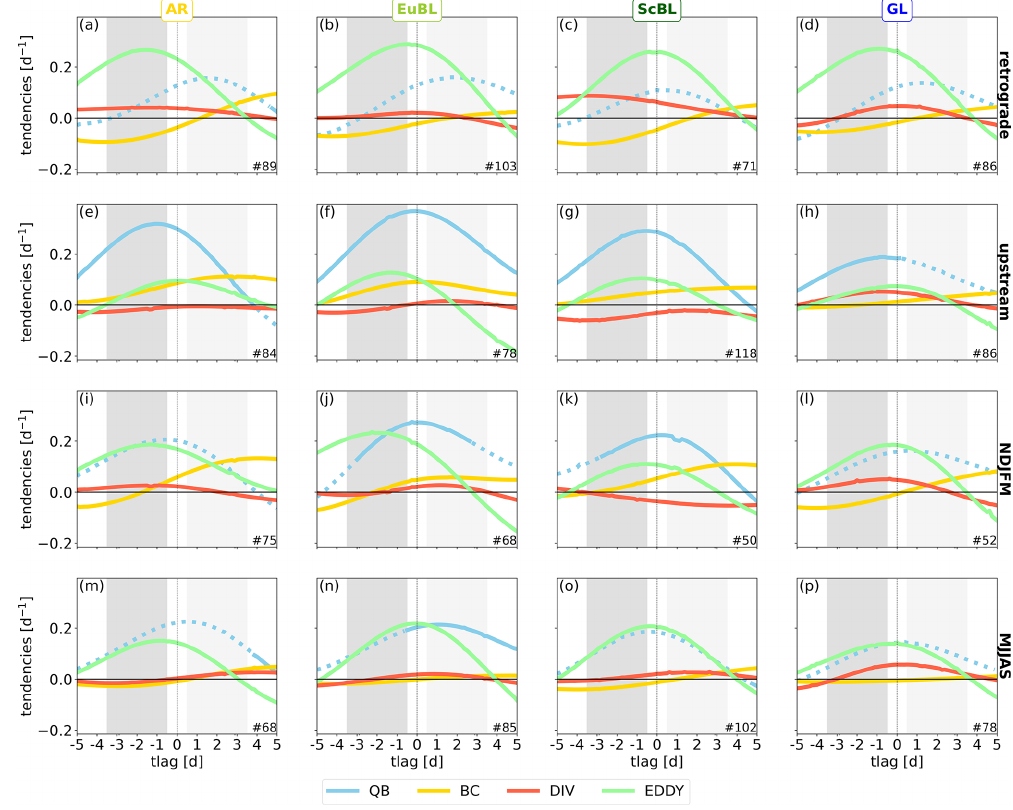
Figure 9. Same as Fig. 7, but for both clusters ( a–d : retrograde, e–h : upstream) and both extended seasons ( i–l : NDJFM, m–p : MJJAS).